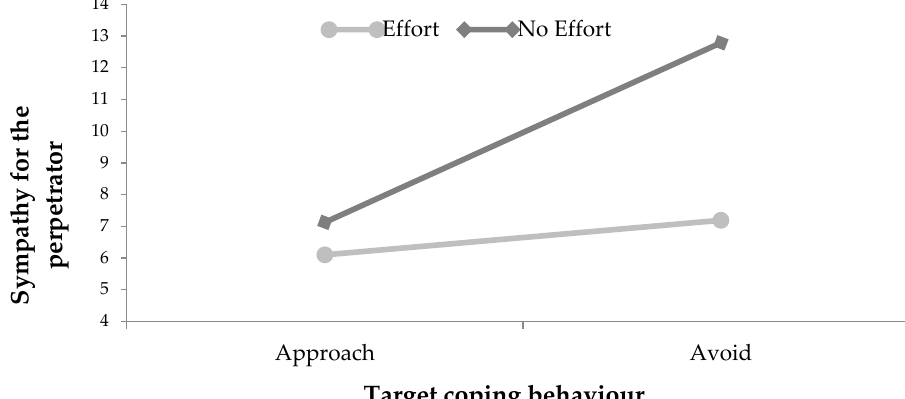
Figure 1. Estimated marginal means of the interaction of perpetrator response behaviour and target coping behaviour on perceived perpetrator responsibility.